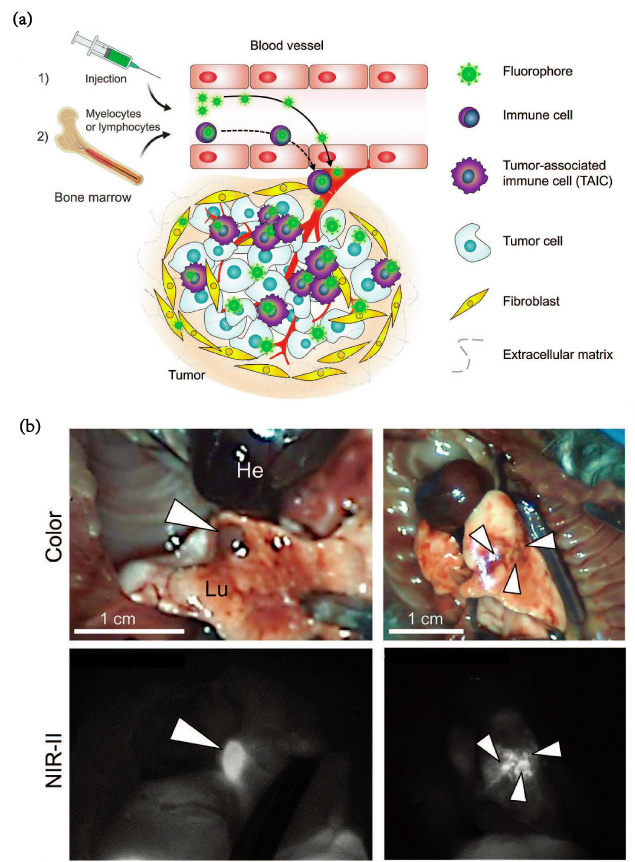
Figure 10. ( a ) Schematic illustration for two-step mechanism of tumor-targeted SH1 fluorophore. ( b ) 50 nmol of SH1 was injected into the mouse model of orthotopic lung cancer tumors 48 h prior to imaging. The white arrowheads indicate lung tumors. (excitation = 808 nm; power density = 30 mW cm − 2 ; exposure time = 25 ms; optical filter = 1070 nm LP) [92]. Copyright 2022,